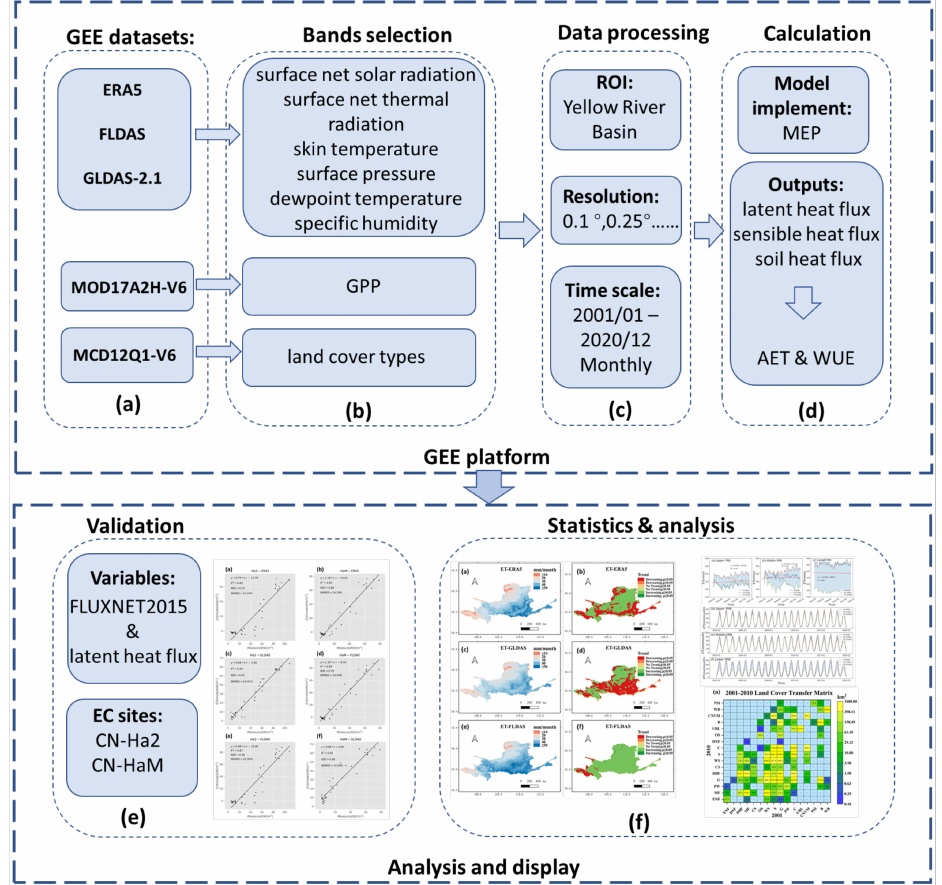
Figure 1. Flow chart of the framework based on Google Earth Engine platform for estimating the actual ET and Water Use Efficiency (WUE): ( a ) Datasets selected from GEE in this article; ( b ) Variables selected from datasets; ( c ) Processing of input data; ( d ) Implementation and outputs of MEP model; ( e ) The validation of results; ( f ) Statistics and analysis of the